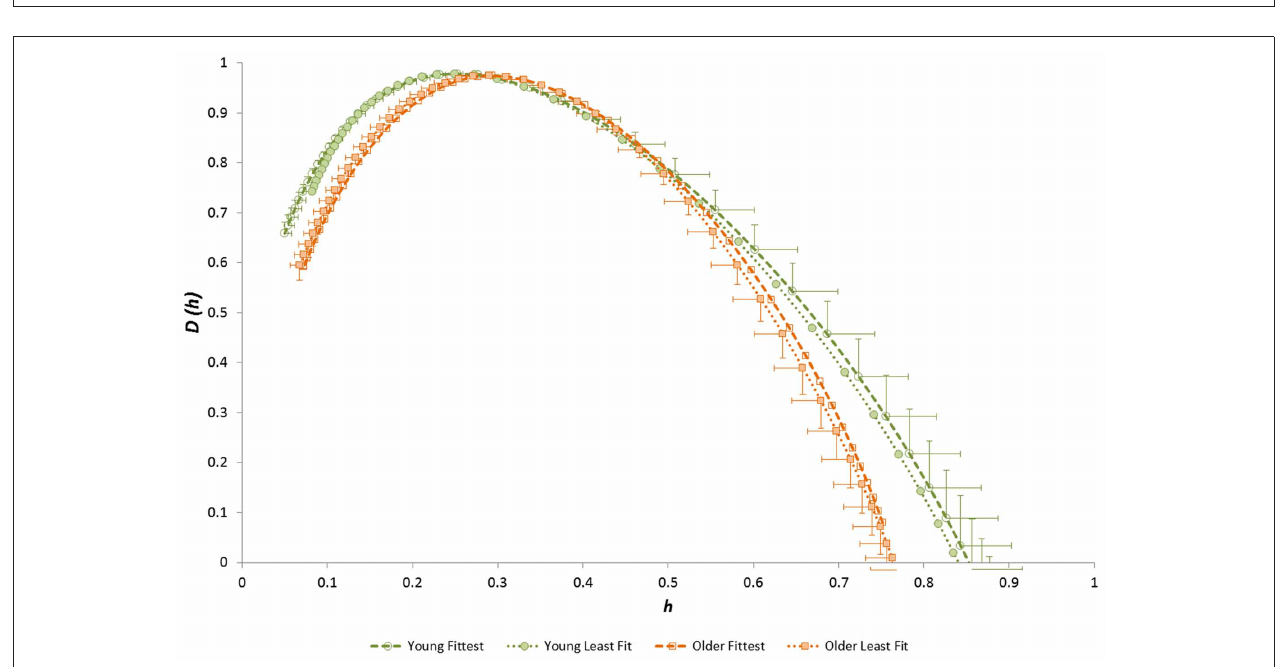
FIGURE 8 | Singularity multifractal spectra for younger and older groups (shown for the Evening period; other time periods showed similar results).